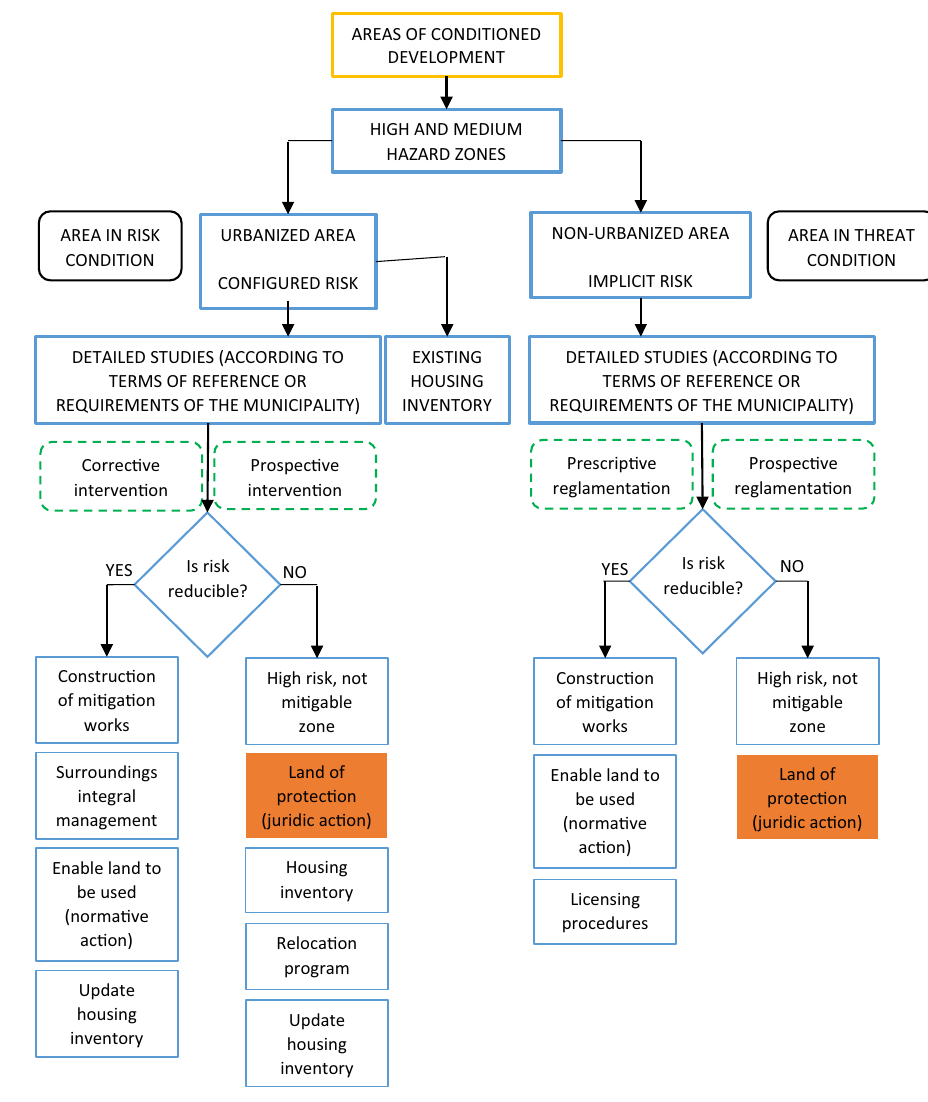
Fig. 4 Flowchart of the